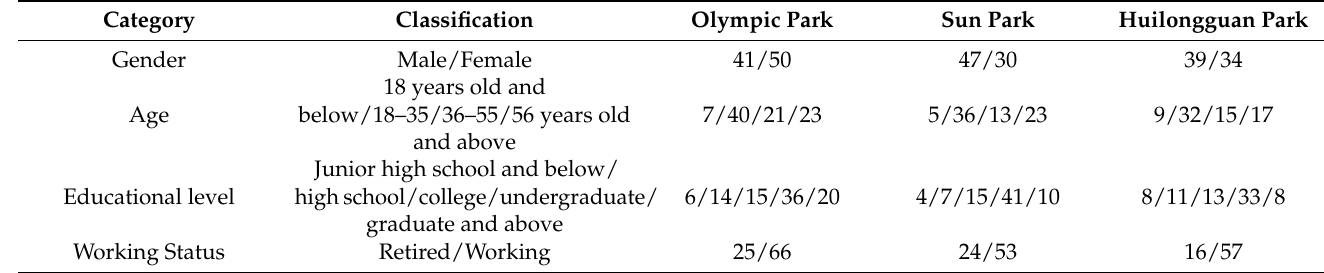
Table 3. Basic information and the number of respondents in three parks.